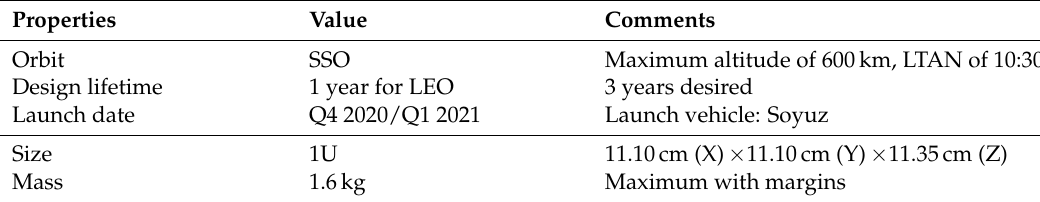
Figure 2. UVSQ-SAT computer aided design representation with an arrangement of all Printed Circuit Boards (PCBs). The UVSQ-SAT payload instruments are shown (Earth Radiative Sensors (ERS) and DEep uV INnovative detector technologies for Space observations (DEVINS)), except the three axis accelerometer/gyroscope/compass, which is located above the payload electronic board. Table 2. UVSQ-SAT CubeSat